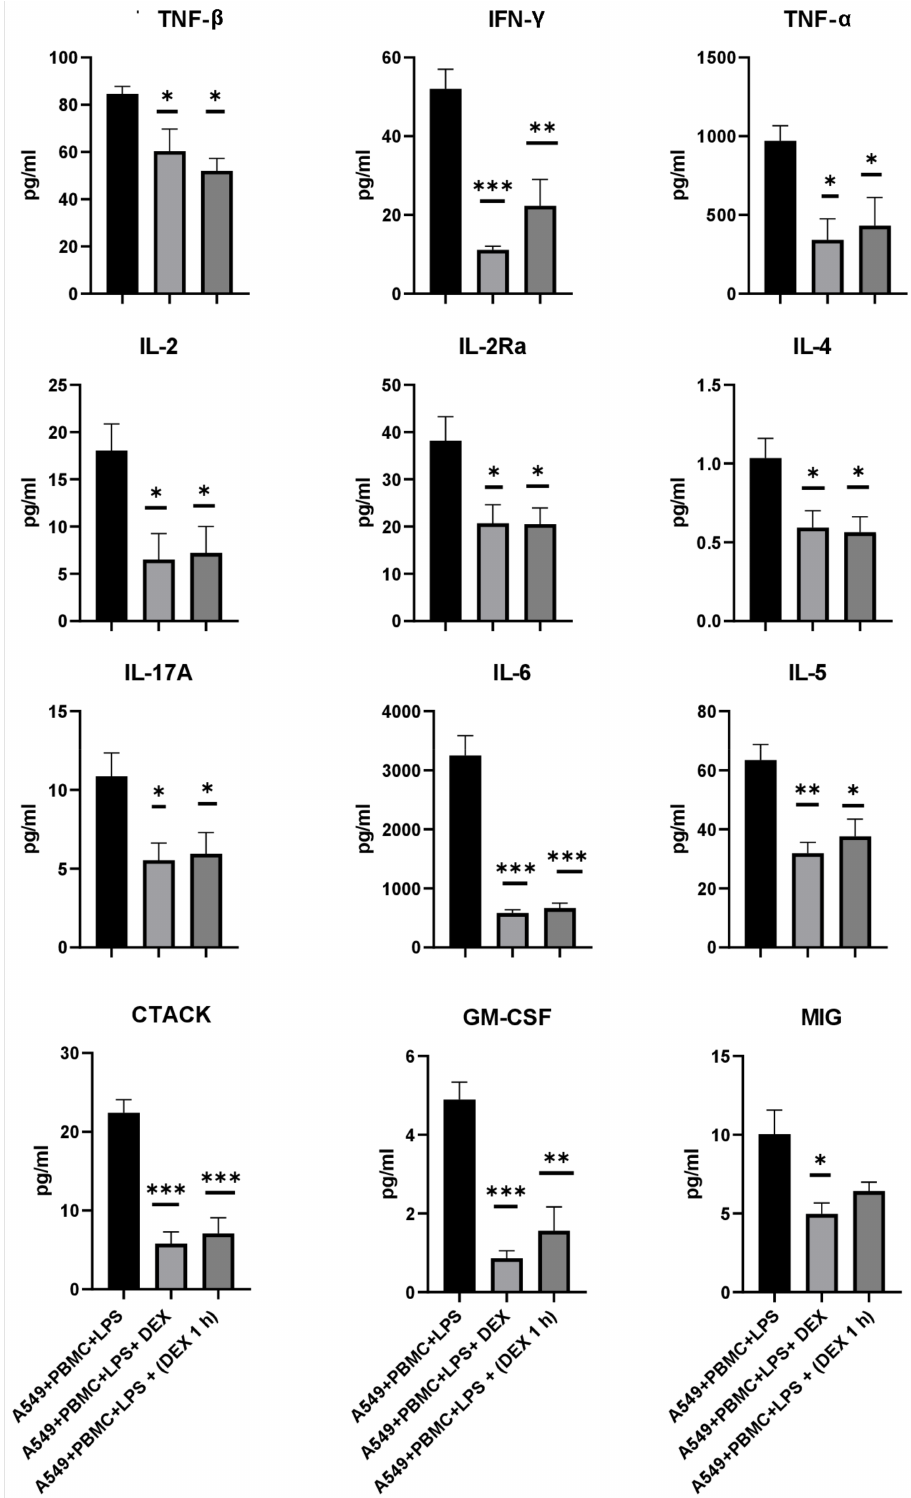
Figure 6. Effect of dexamethasone on cytokine/chemokine concentrations in the conditioned medium from the model system after 24 h treatment. The data are presented as a mean ± SEM, n = 3. * p < 0.05, ** p < 0.01, *** p < 0.001; the significance from the A549 + PBMC + LPS is assessed by a one-way ANOVA with the Tukey’s multiple comparisons